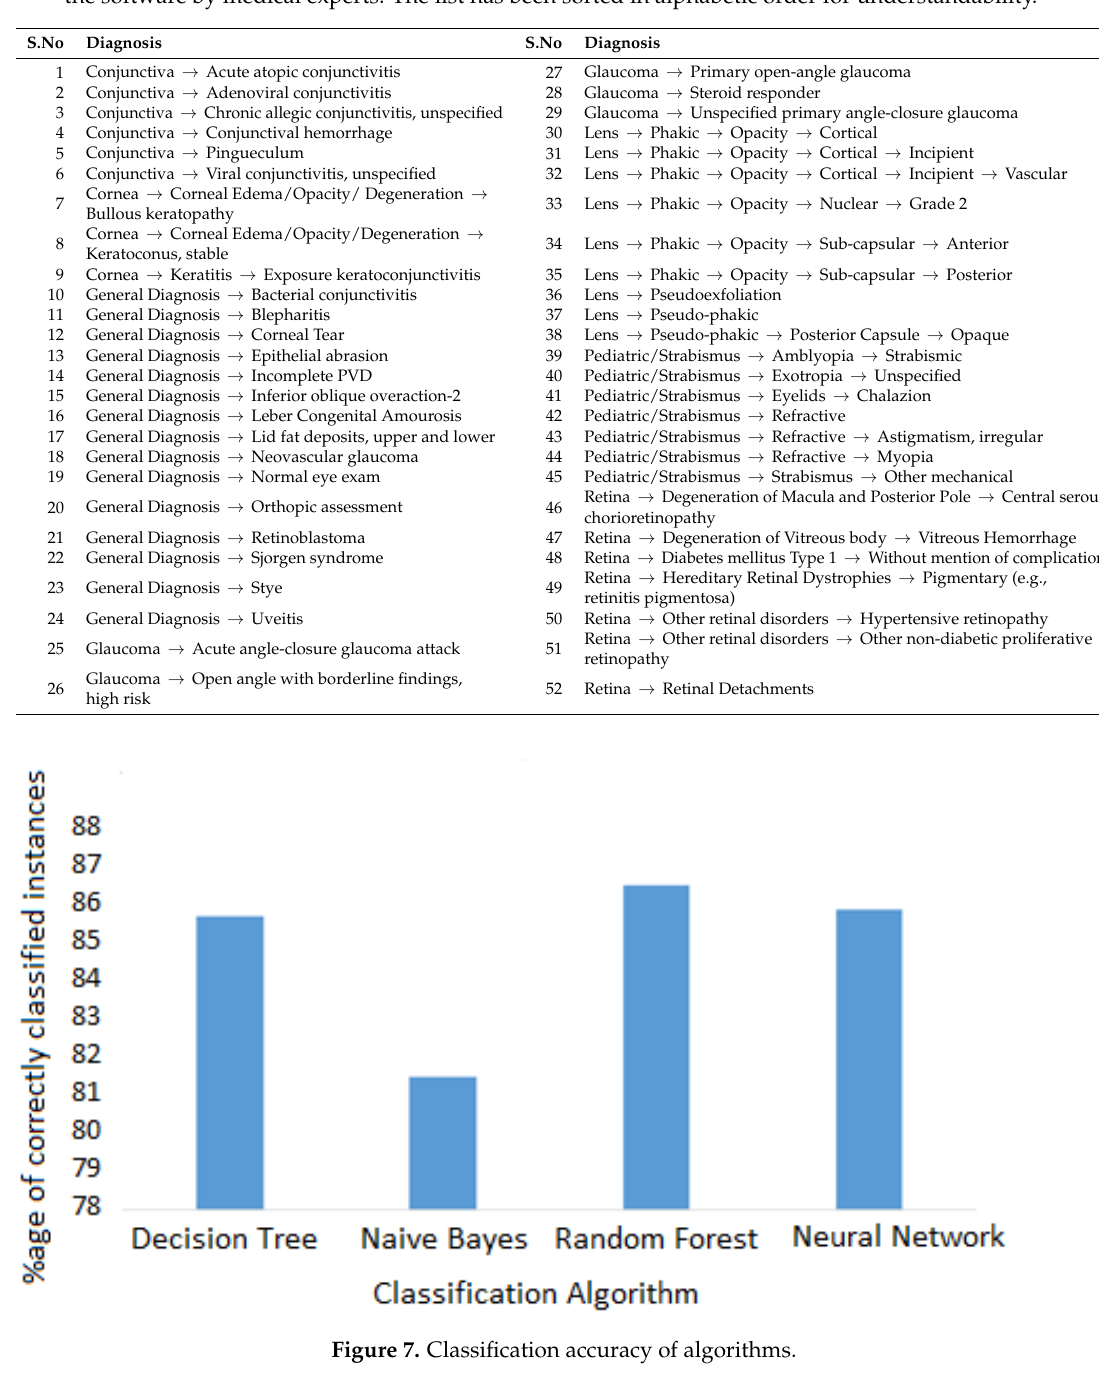
Table 6. Fifty-two different diagnoses (classes for classification) for which the data were recorded in the software by medical experts. The list has been sorted in alphabetic order for understandability.